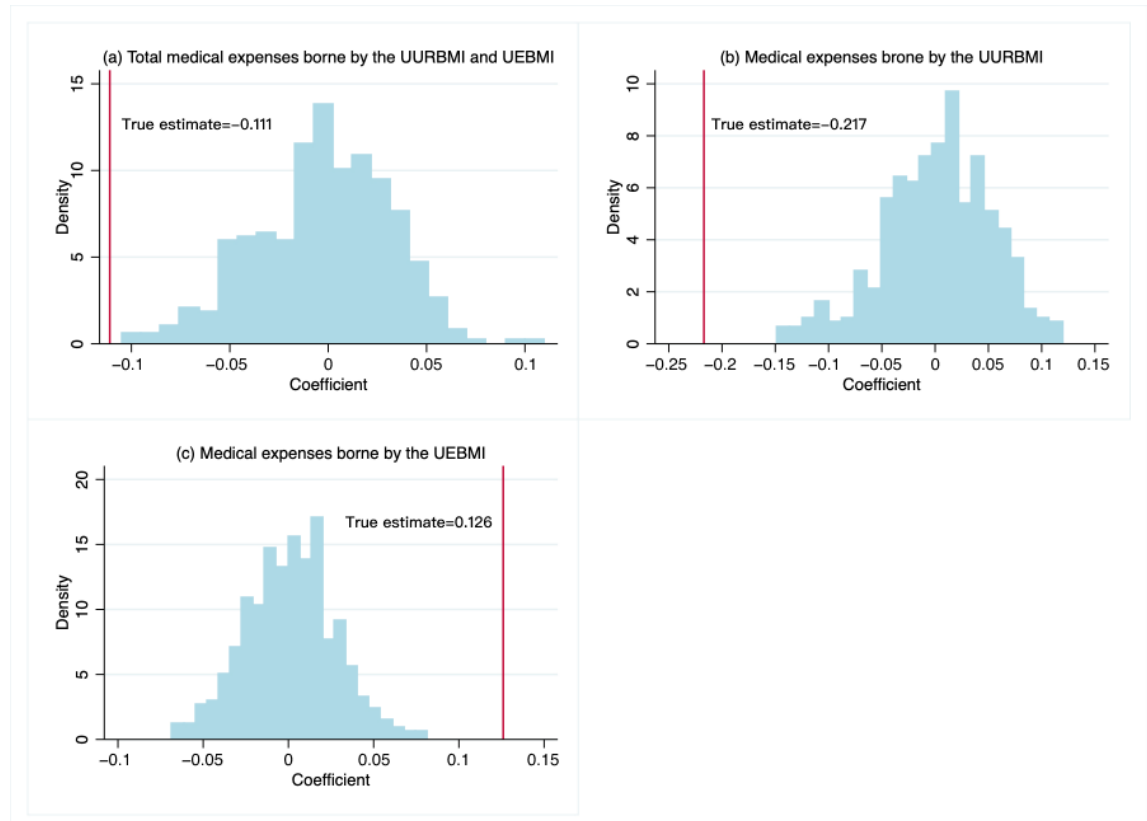
Figure 4. Distribution of policy effects from the placebo test. The graphs show the frequency distribution of 500 estimated fake treatment coefficients from placebo tests. We assumed that any of the other counties except those in the CZT region implemented the SPR. Models in figures ( a – c ) were specified the same as in column 3 of Table 2 and columns 1 and 2 in Table 3. The vertical lines show the true estimate of policy effects, which are shown in Tables 2 and 3.